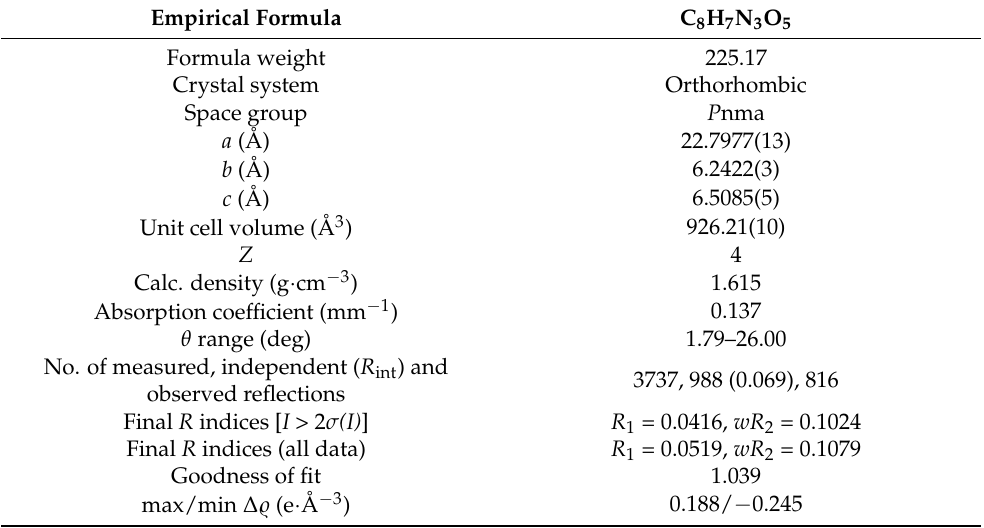
Table 1. Crystallography parameters of